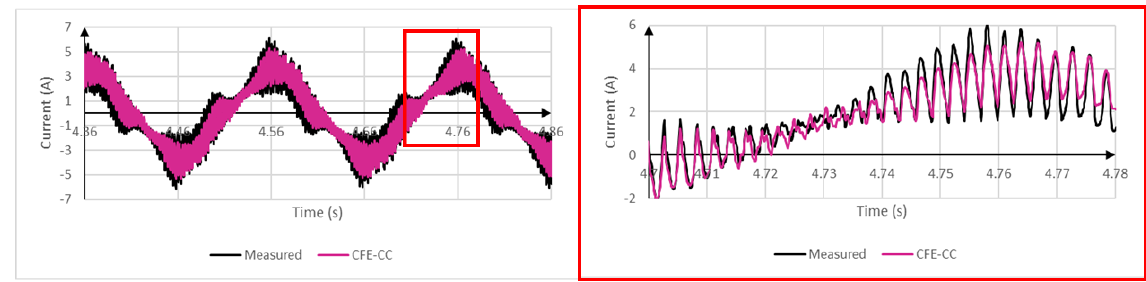
Figure 16. Rotor current in winding a r during load operation and fed through TRIACs, enlarged on right